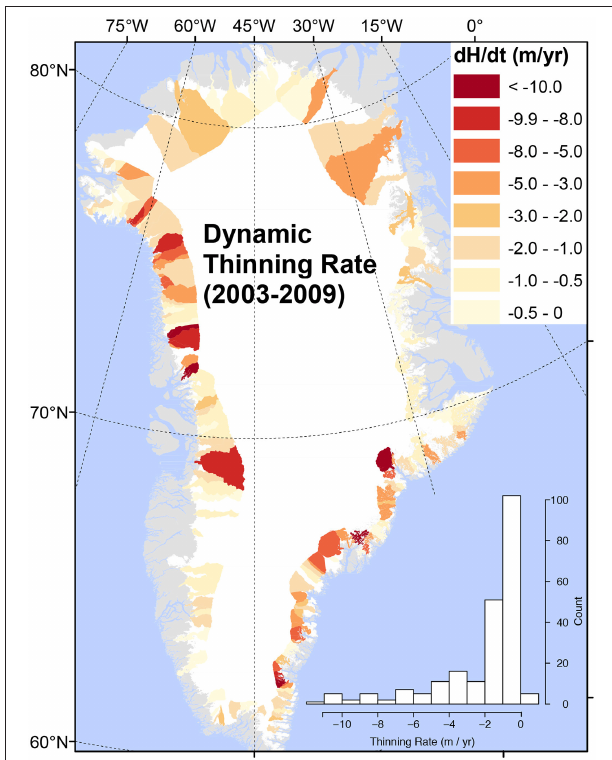
FIGURE 1 | Maximum dynamic thinning rates within each catchment for the period 2003–2009. Shown at lower right is a histogram of the 223 tidewater glaciers with terminus widths greater than 1